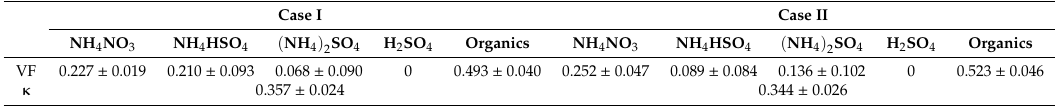
Table 5. Calculated volume fractions (VF) of NH (cid:2872) NO (cid:2871) , NH (cid:2872) HSO (cid:2872) , (NH (cid:2872) ) (cid:2870) SO (cid:2872) , H (cid:2870) SO (cid:2872) , and organics, and the hygroscopicity parameter ( 𝜿 ) for Case I and Case II.